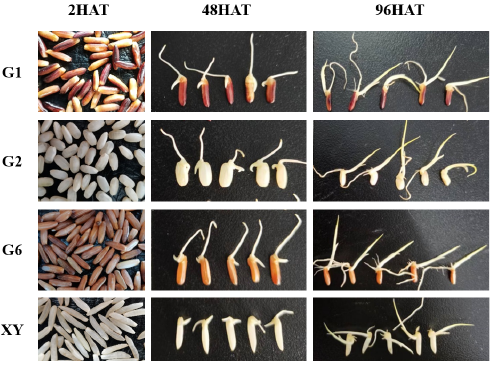
Figure 2. Morphological diagram of brown rice at different stages of germination. Treatments: 2 h after seed soaking treatment (2HAT), 48 h after seed soaking treatment (48HAT), and 96 h after seed soaking treatment (96HAT). Varieties: Guanghei1 (G1), Guichao2 (G2), Guanghong6 (G6), Xiangyaxiangzhan (XY).